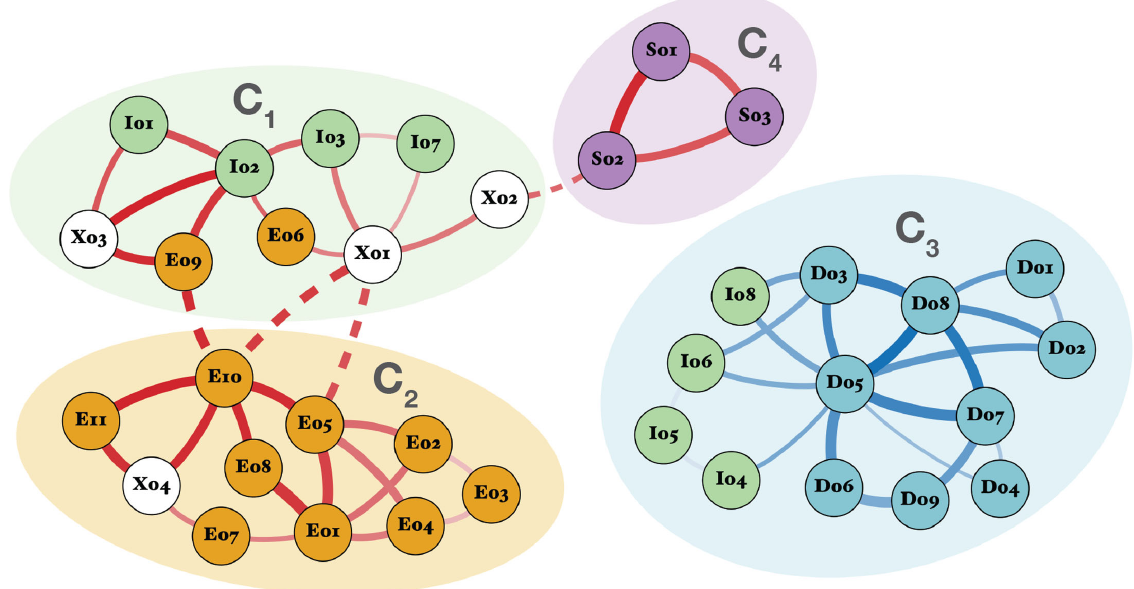
FIG. 3. The ASES similarity network. The node colors indicate the principal component that the survey item was loaded into; mentoring and research experience, E (orange), professional development, D (teal), social and academic integration, I (green), financial support, S (purple), or not loaded (white). The shaded regions represent the clusters identified by the fast-greedy clustering algorithm; C C C C 1 (green), 2 (orange), 3 (teal), or 4 (purple). The edge thickness represents the amount of similarity. The edge color indicates the edge temperature, i.e., whether the edge is created via mutual agree (red) or disagree (blue) answers. The dashed edges indicate connections that span across